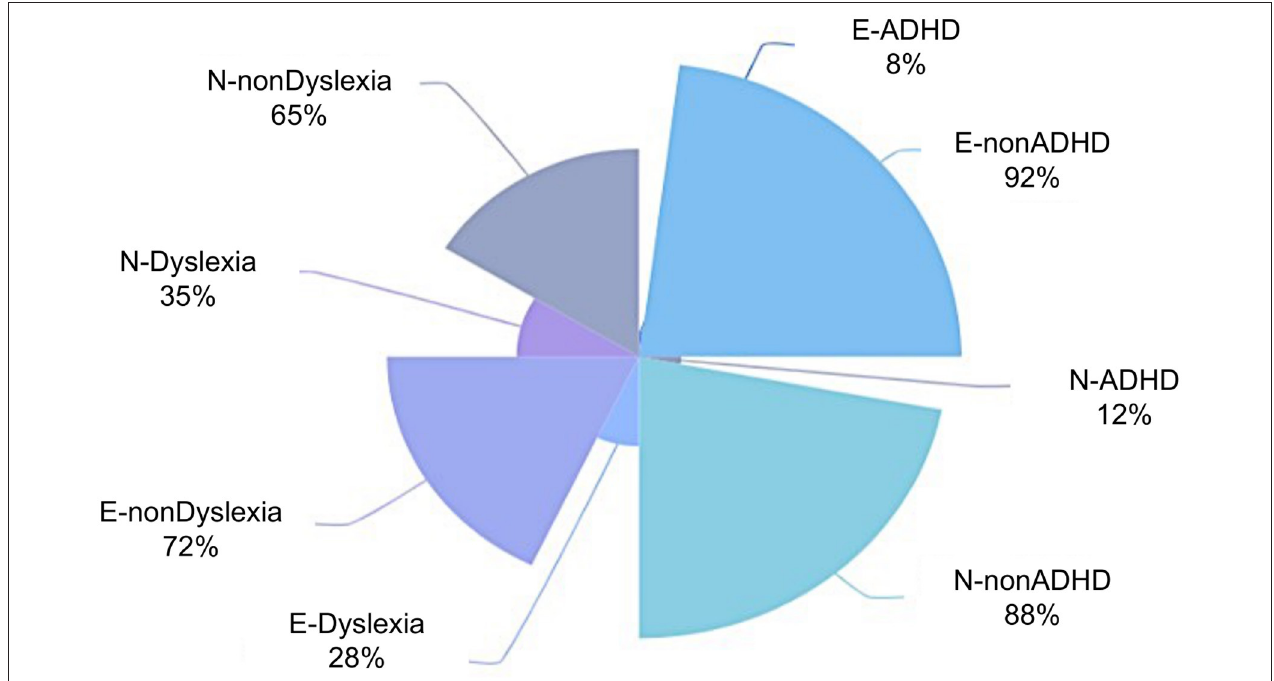
FIGURE 1 | ADHD and Dyslexia distribution among two